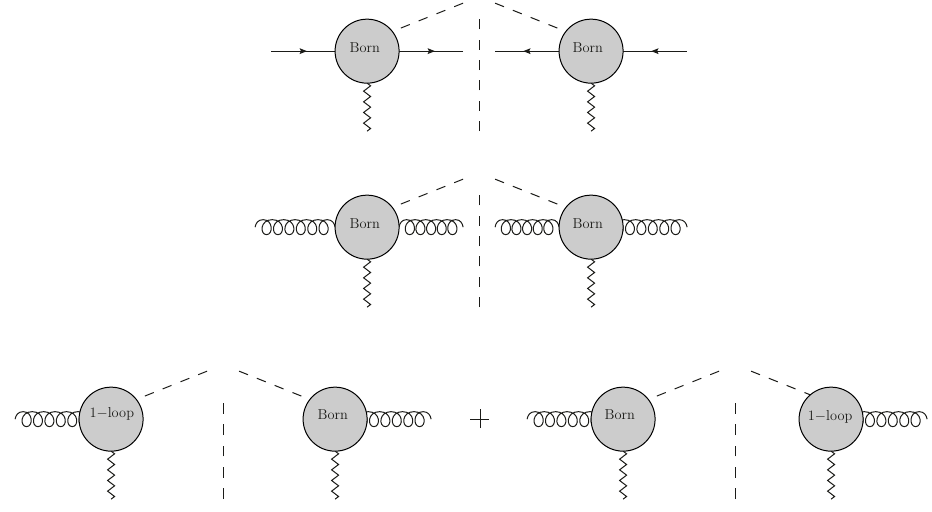
Figure 6 . Schematic description of the calculation of the impact factor at the NLO. In the first figure from above the hard process is initiated by a quark, and an additional quark is produced through the cut. Note that this quark “crosses” the cut to indicate that we will integrate on its kinematic